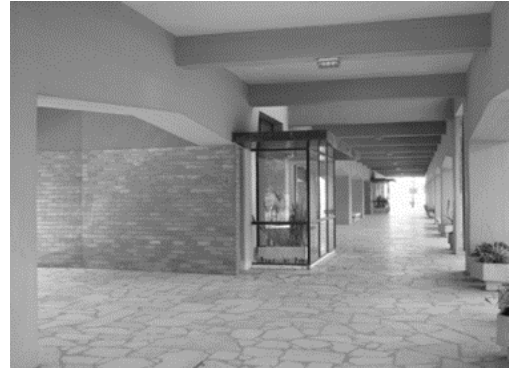
Figure 11. Entrances.